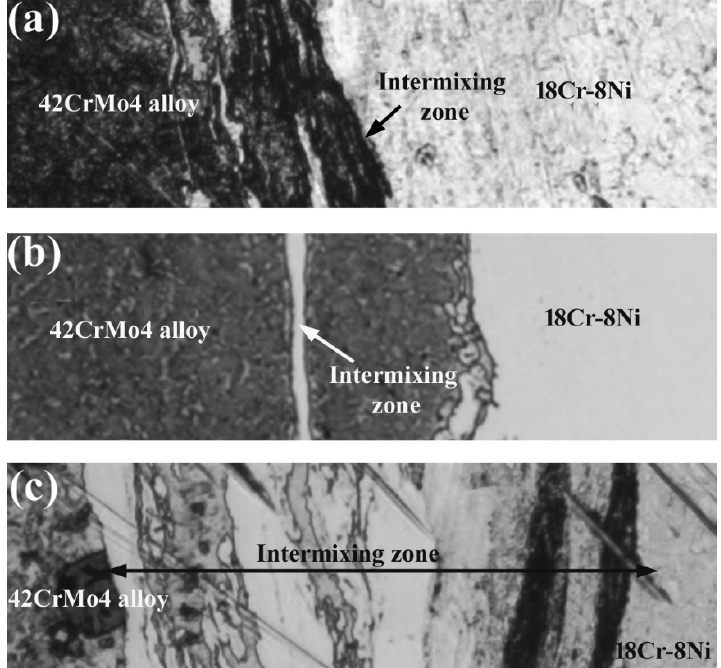
Figure 15. Interface microstructure of the solid state additive manufacturing of dissimilar layers at different intermixing zones (burn-off length) ( a ) 2 mm, ( b ) 4 mm and ( c ) 6 mm.